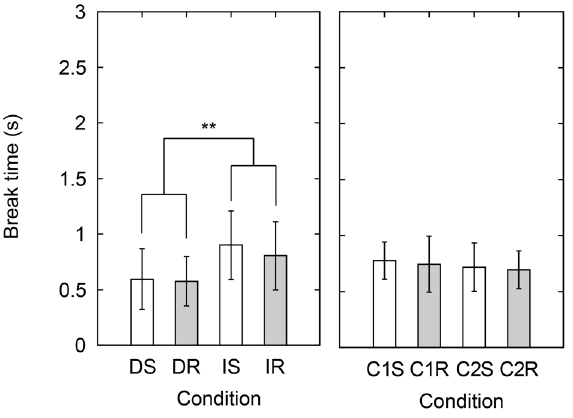
Figure 9. Averages of break time in the various conditions. Averages from all participants except participant 1. Left panels: DS, DR, IS, and IR and right panels: C1S, C1R, C2S, and C2R indicate each condition. D, I, C1, and C2 mean discrimination task, identification task, 1 st control condition, and 2 nd control condition, and S and R mean smooth group and rough group. Error bars indicate the standard deviation. **indicates p , 0.01 with repeated measures ANOVAs.